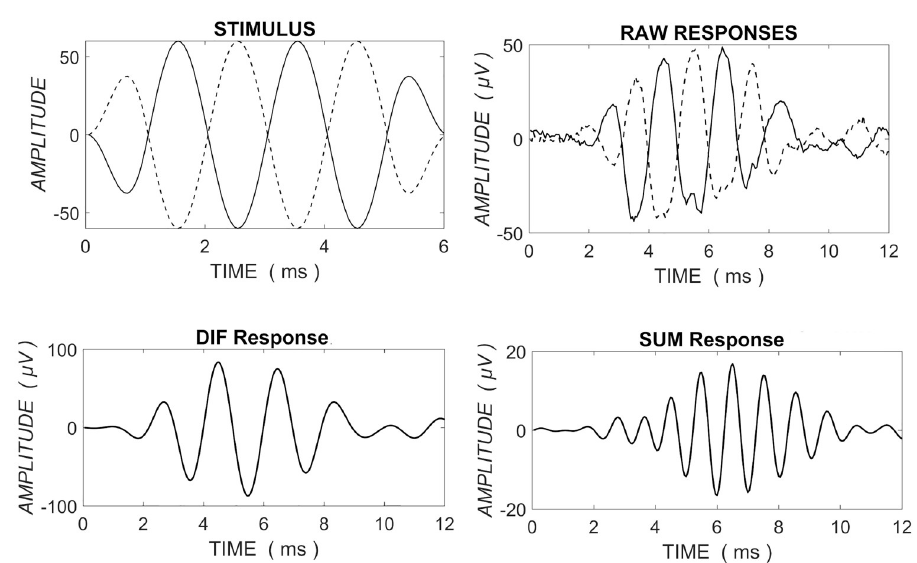
Fig 1. Top panels: left shows the stimulus of alternating polarity and right shows the raw responses recorded for both condensation and rarefaction stimuli. Bottom panels: DIF response calculated by subtracting rarefaction and condensation responses is on the left while the SUM calculated by the addition of the responses is on the right.